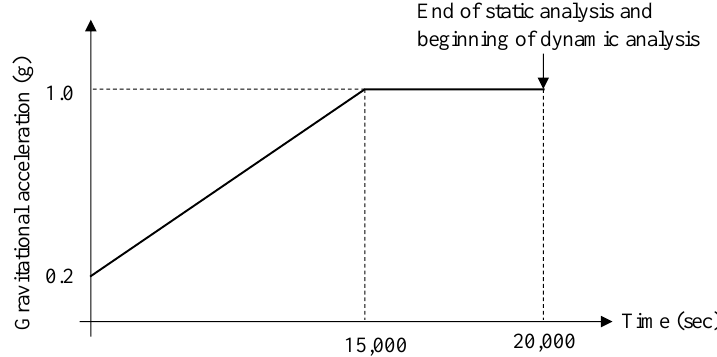
Figure 6. Gravity load – time history for static analysis.